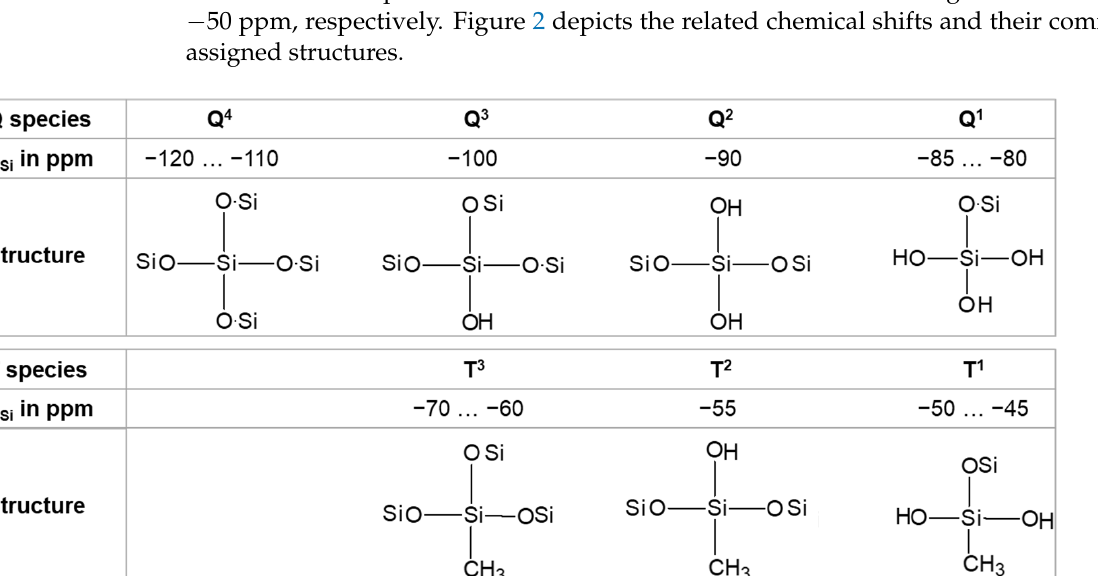
Figure 3. 29 Si MAS NMR spectra of the ( a ) silylated and ( b ) non ‐ silylated silica xerogels.